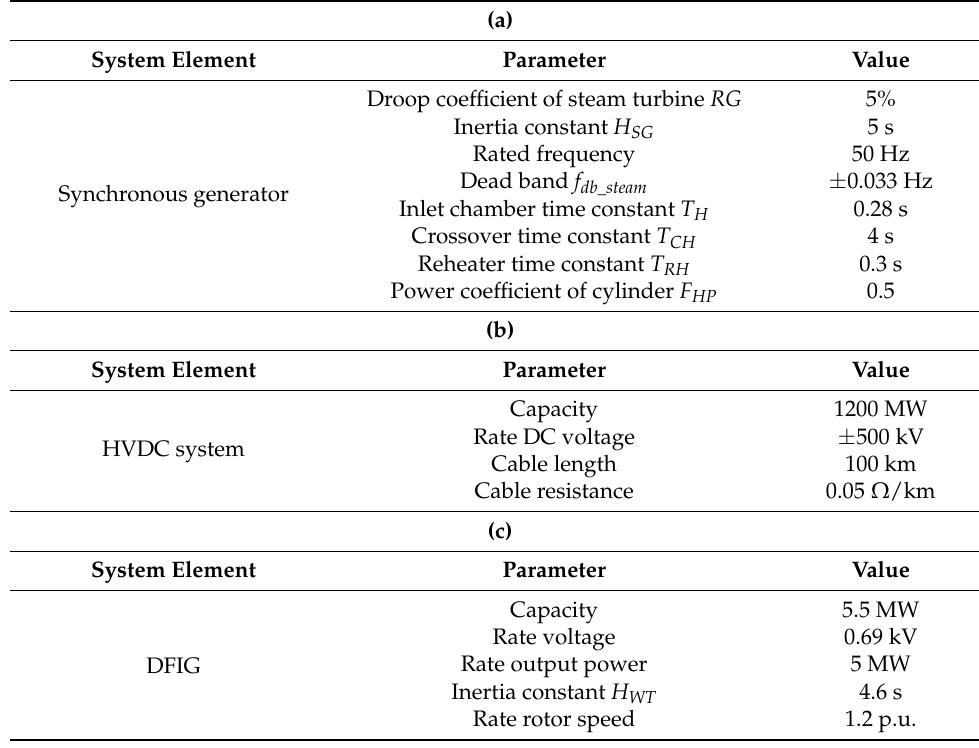
Table 3. Parameters of the test system. ( a ) Parameters of the SG, ( b ) parameters of the HVDC system, and ( c ) parameters of the DFIG.